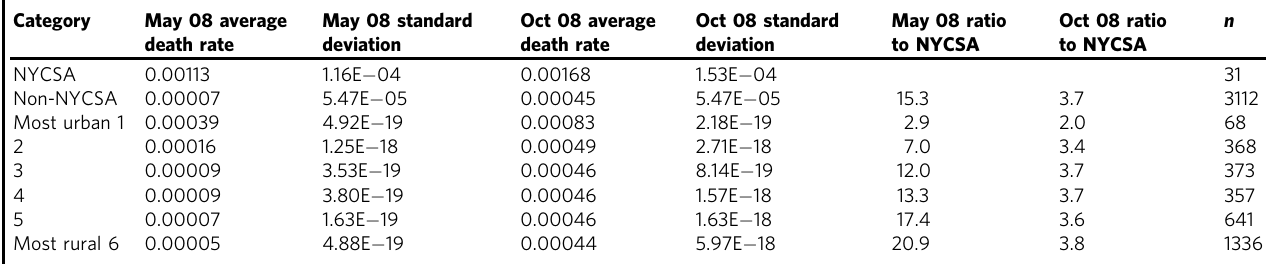
Table 4 Averaged COVID-19 death rates by county